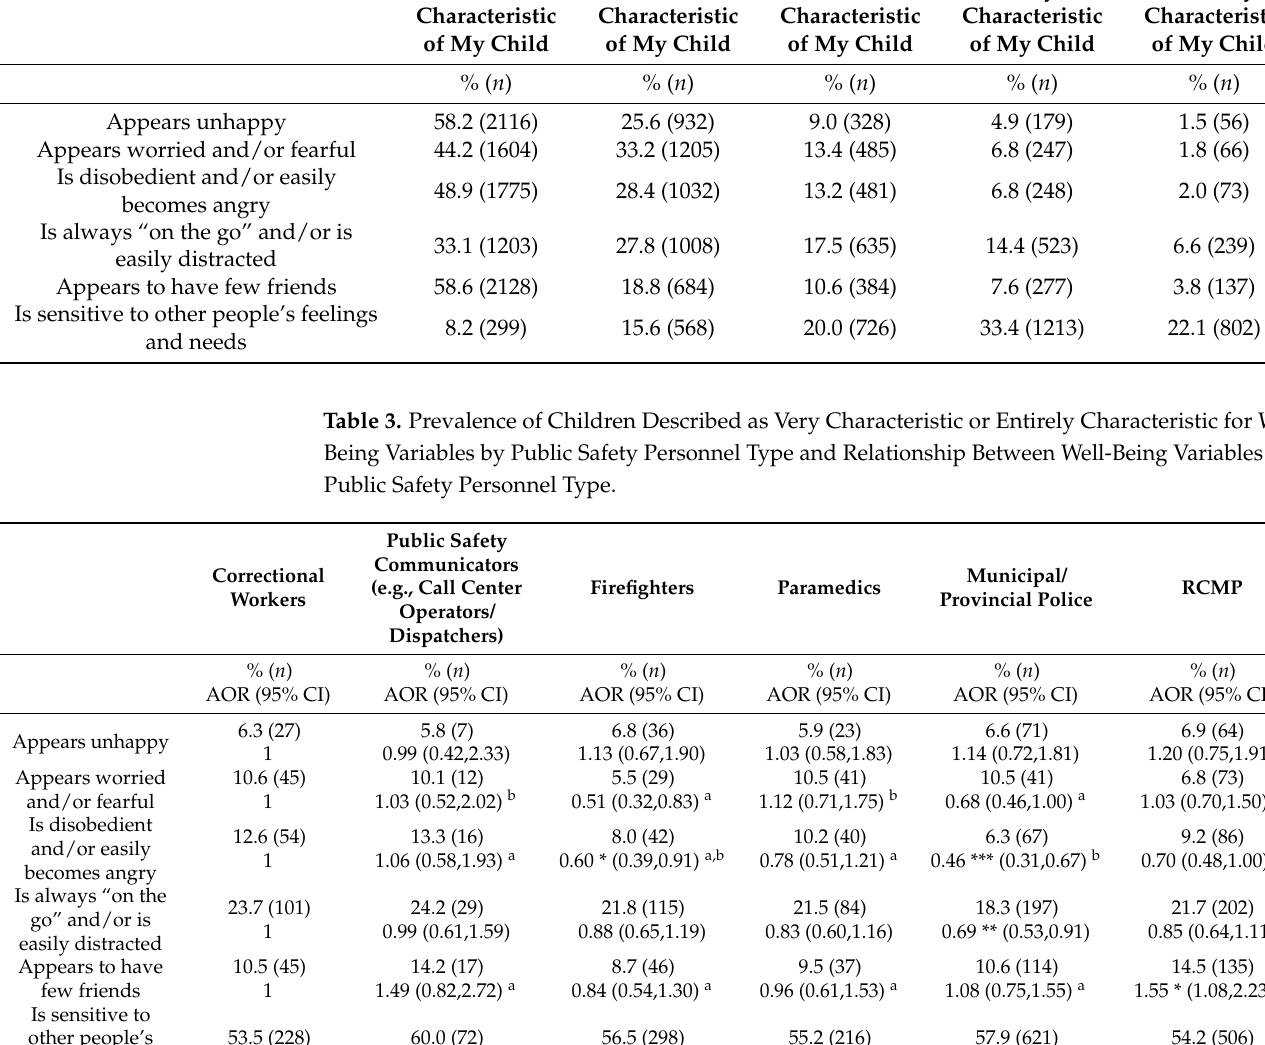
Somewhat Characteristic of My Child